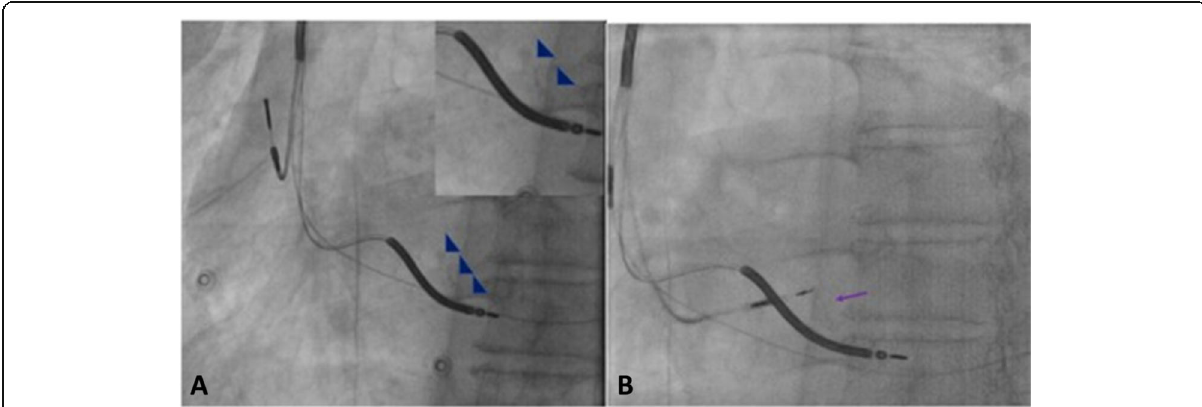
Fig. 6 a Extensive calcification of septum (highlighted by blue arrows), due to which the clockwise torque on the lead was not being transmitted forward for penetration ( b ), instead was coming back causing the lead to make multiple turns and get